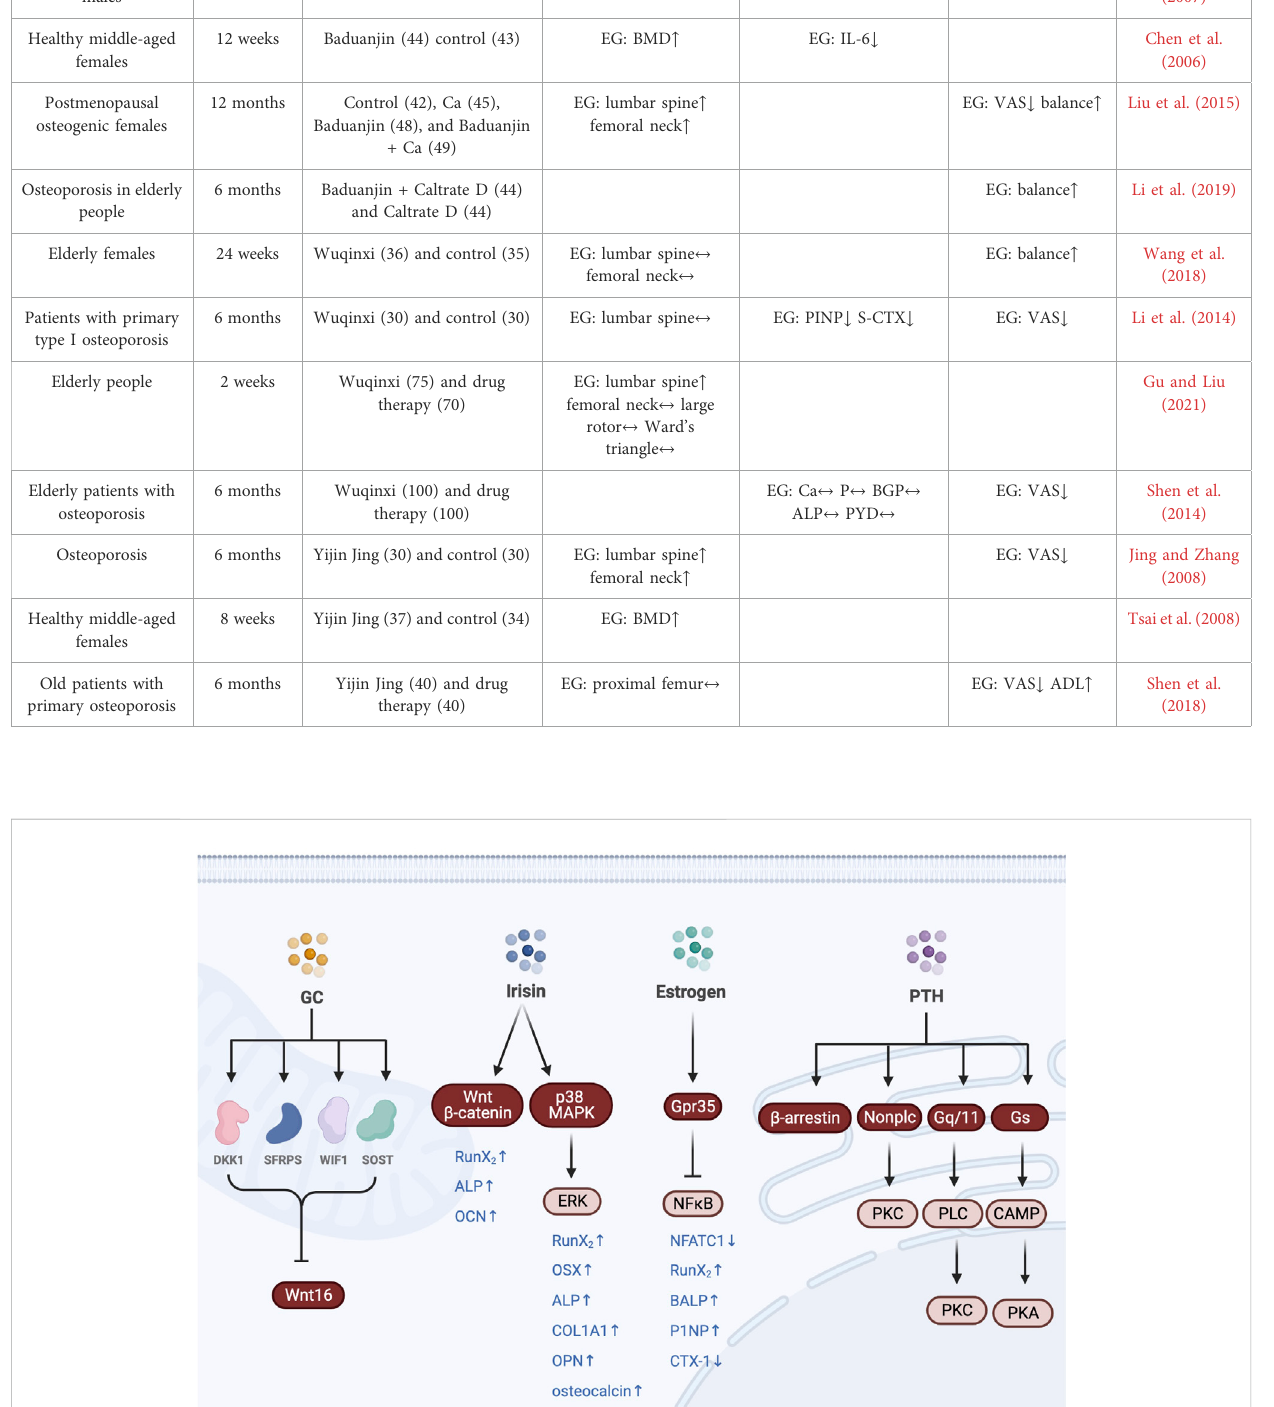
FIGURE 2 Exercise regulates bone metabolism by regulating the hormone secretion of the endocrine